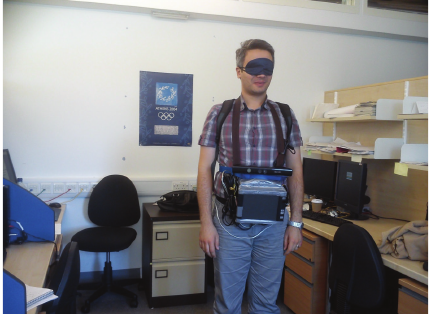
Figure 9: System testing by a blindfolded